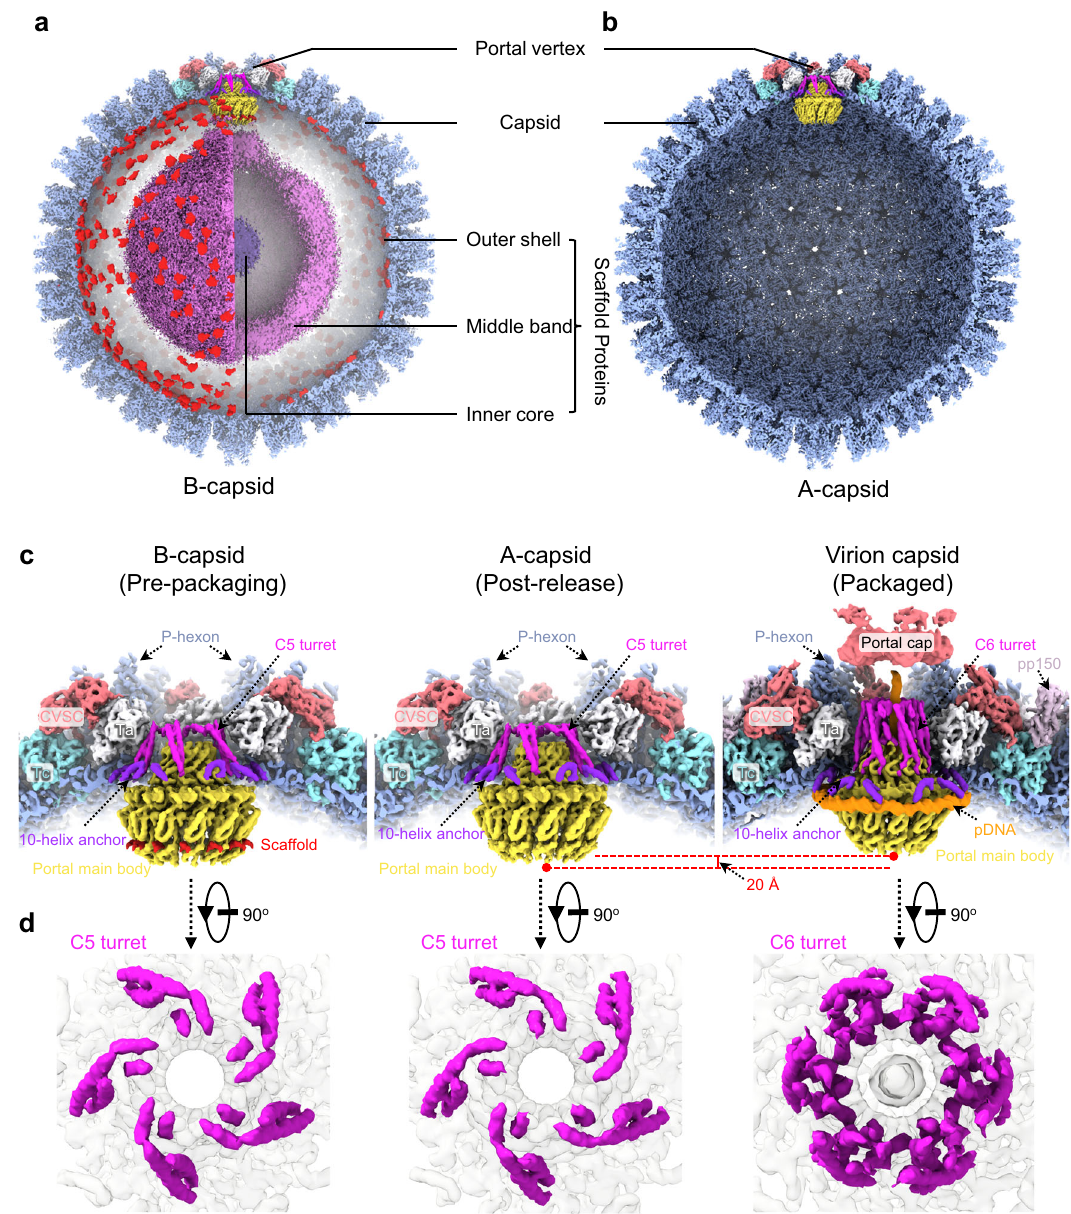
Fig.1|Asymmetricreconstructionsofcapsidsandinsituportalsofthehuman cytomegalovirus (HCMV) A- and B-capsids. Composite structures of the HCMV B-capsid ( a ) and A-capsid ( b ), respectively. The front-halves of both capsid shells (lightblue)areremovedtoshowtheirinternalcomponents.Thefront-rightquarter of the scaffold in ( a ) is removed to show the inner three-layer scaffold (the inner core and middle band are radially colored from dark to medium purple and the outershellishighlightedinred).Theportalverticesarecoloredasindicatedbelow in( c ). c Close-upviewsoftheportalvertexregionsinB-(left),A-(middle)andvirion (right) capsids. The capsid shell components of the portal vertex are colored by protein. The portal is colored by domain. For both B- (left) and A-capsid (middle), the composite cryoEM maps were assembled from reconstructions of C1